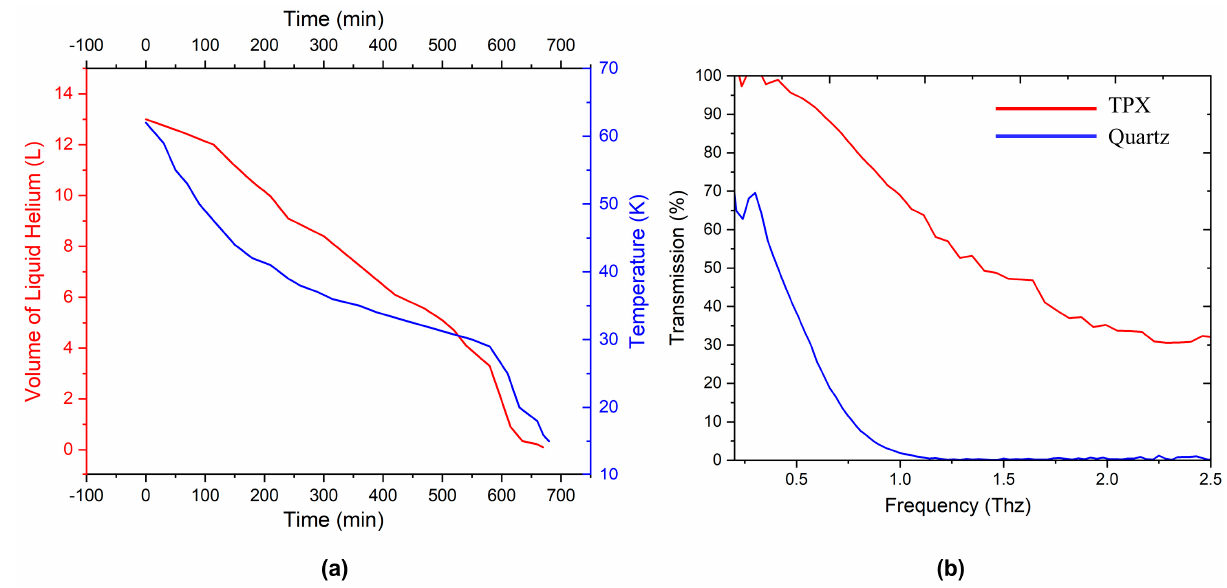
Figure 4. ( a ) Time dependence of temperature and liquid helium volume during cryostat cooling. ( b ) Transmittance of the terahertz frequency band through the optical windows (30 mm thick) made of different materials.